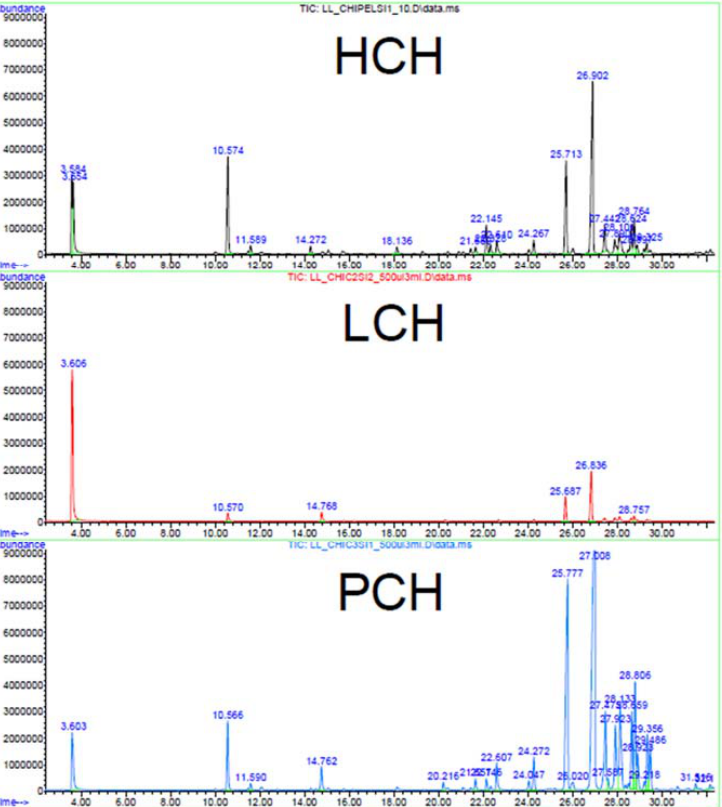
Figure 4. Superimposition of HS-SPME/GC-MS chromatograms of the HCH, LCH, and PCH samples with the respective retention time for each compound.